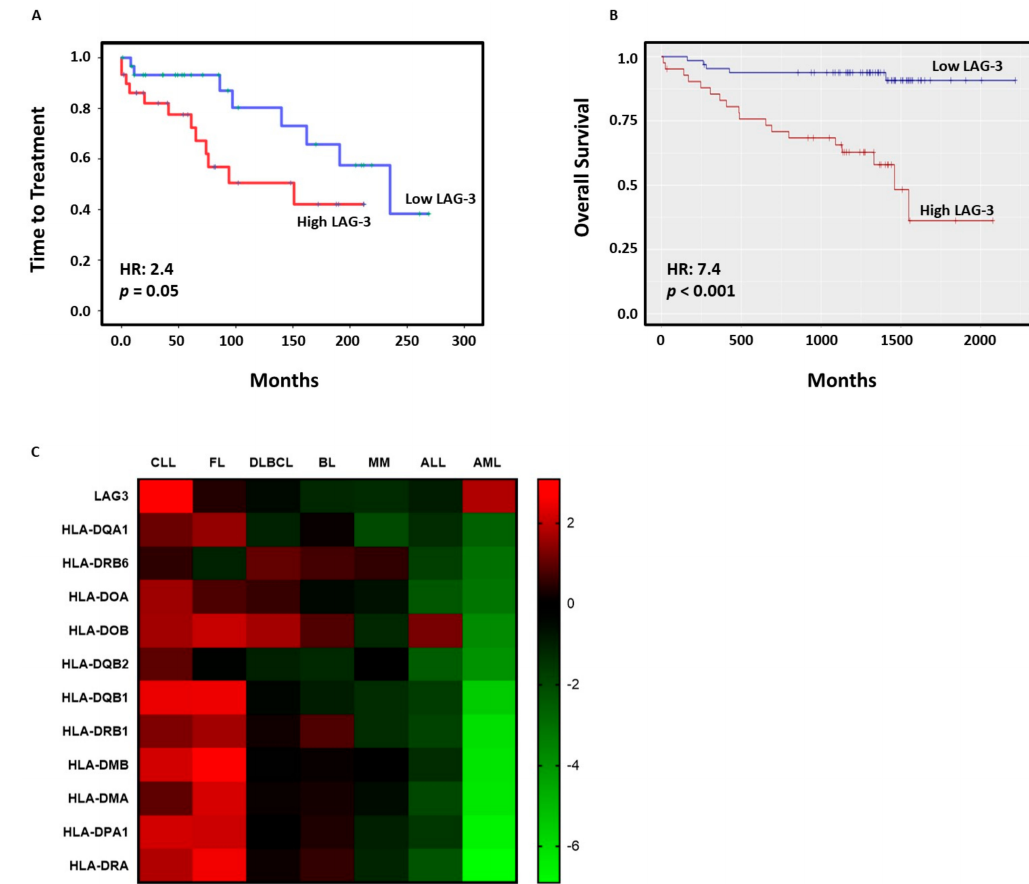
Figure 3. High LAG-3 expression on leukemic cells correlates with poor outcome in CLL. ( A ) Kaplan-Meier survival analysis relative to LAG-3 surface expression and TTT in 61 patients with CLL; ( B ) In silico analysis of OS in 107 patients with CLL using ShinyGeo online tool (GSE22762); ( C ) Heatmap representing z-score corresponding to the expression of LAG3 and MHC class II genes and its influence in OS in diverse hematological malignancies analyzed by PRECOG tool (CLL: chronic lymphocytic leukemia; FL: follicular lymphoma; DLBCL: diffuse large B-cell lymphoma; BL: Burkitt leukemia/lymphoma; MM: multiple myeloma; ALL: acute lymphoblastic leukemia; AML: acute myeloid